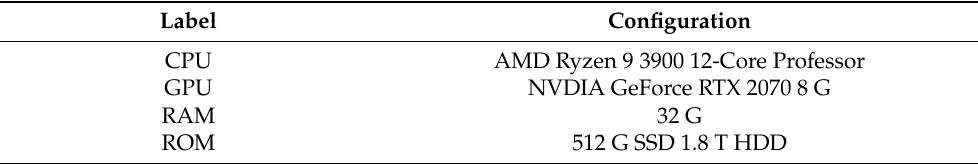
Table 1. Server configuration.